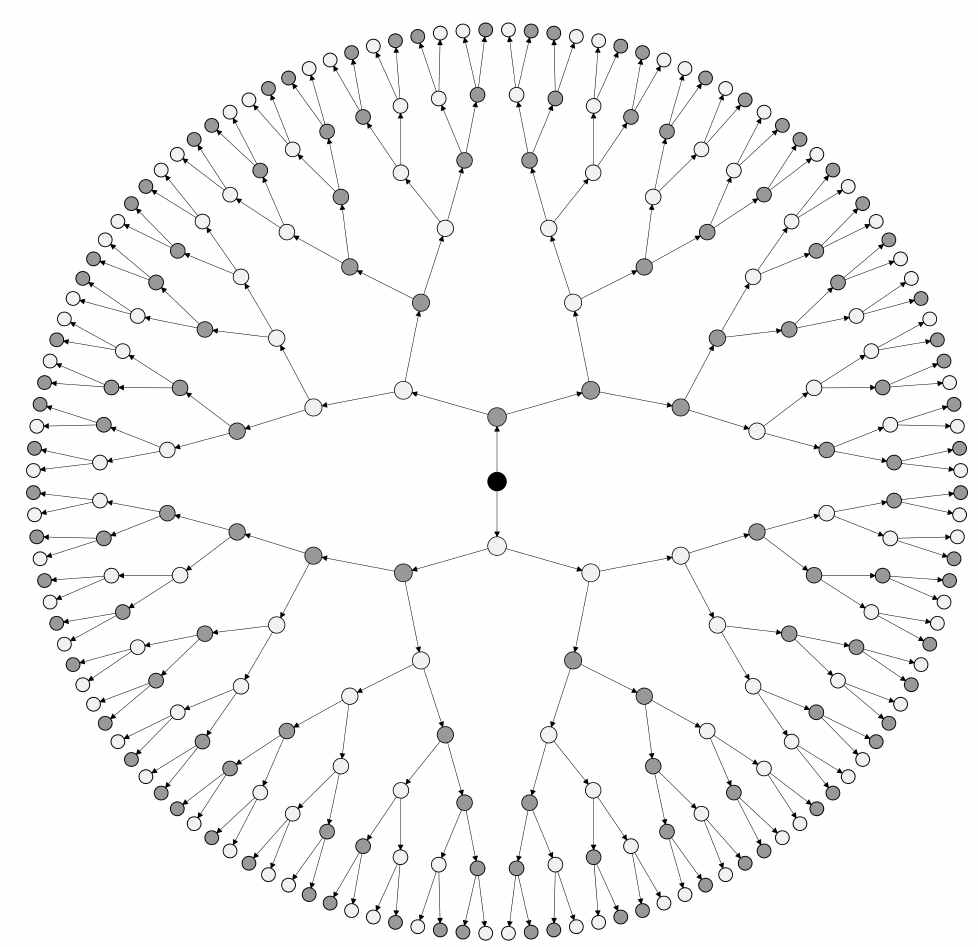
Figure 1. The graph of all possible states and transitions up to 7 impressions. Gray nodes represent states where the last interaction was a click, and white nodes are the ones with the last interaction a non-clicked.